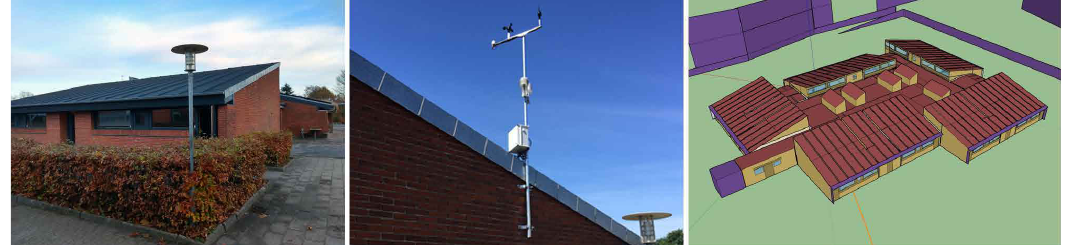
Figure 5. Library building from Gedved School, Denmark. Left: Outdoor image. Middle: Weather station installed on the building’s roof. Right: The building energy model (OpenStudio plugin for SketchUp